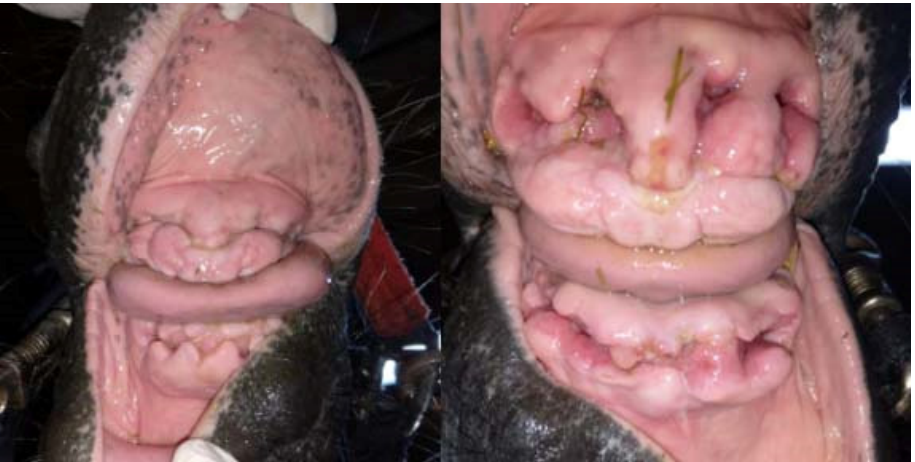
Figure 15. The condition of the teeth pockets 20 days after the procedure (on the left—case 1, on the right—case 2). In a horse not subjected to hyperbaric oxygen therapy (case 2), there is a visible difference in the healing process—the alveolus are much deeper, the gums are less shrunken, and the erythema is still visible.